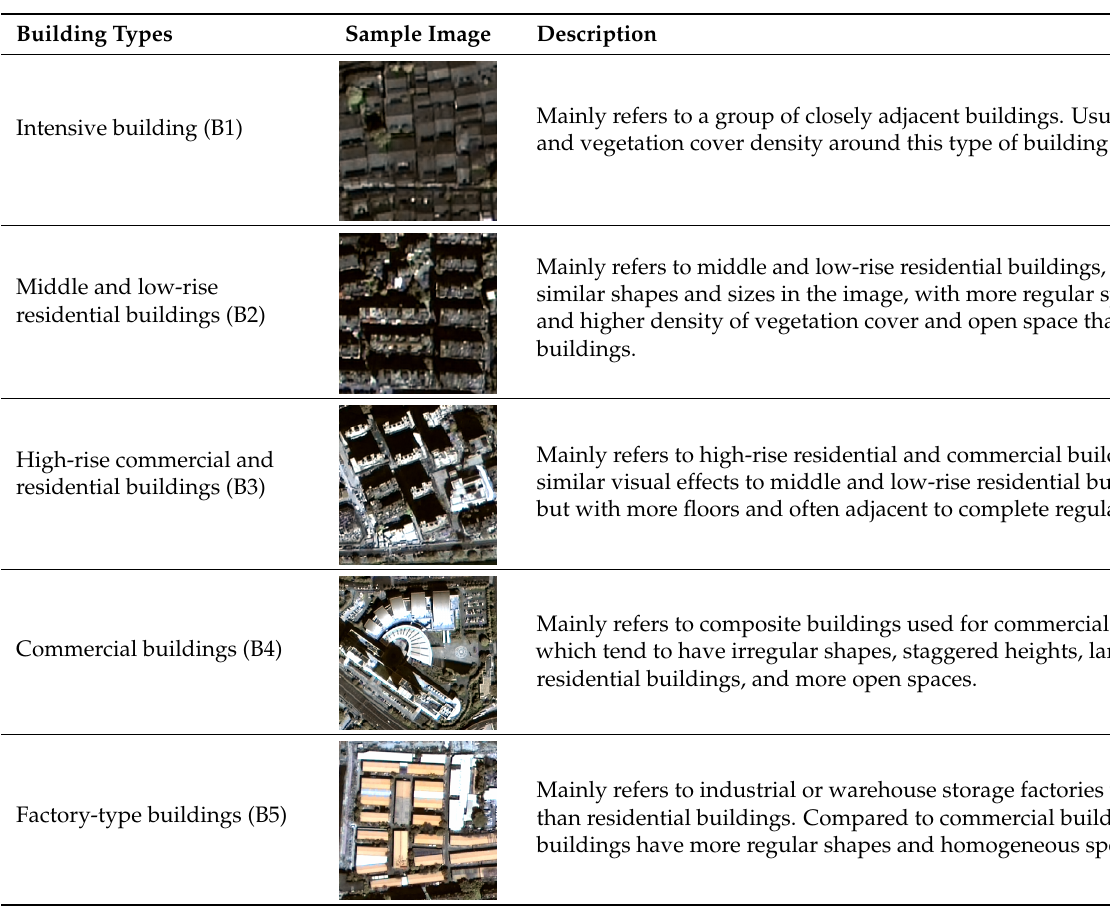
Table 1. Demonstration of building